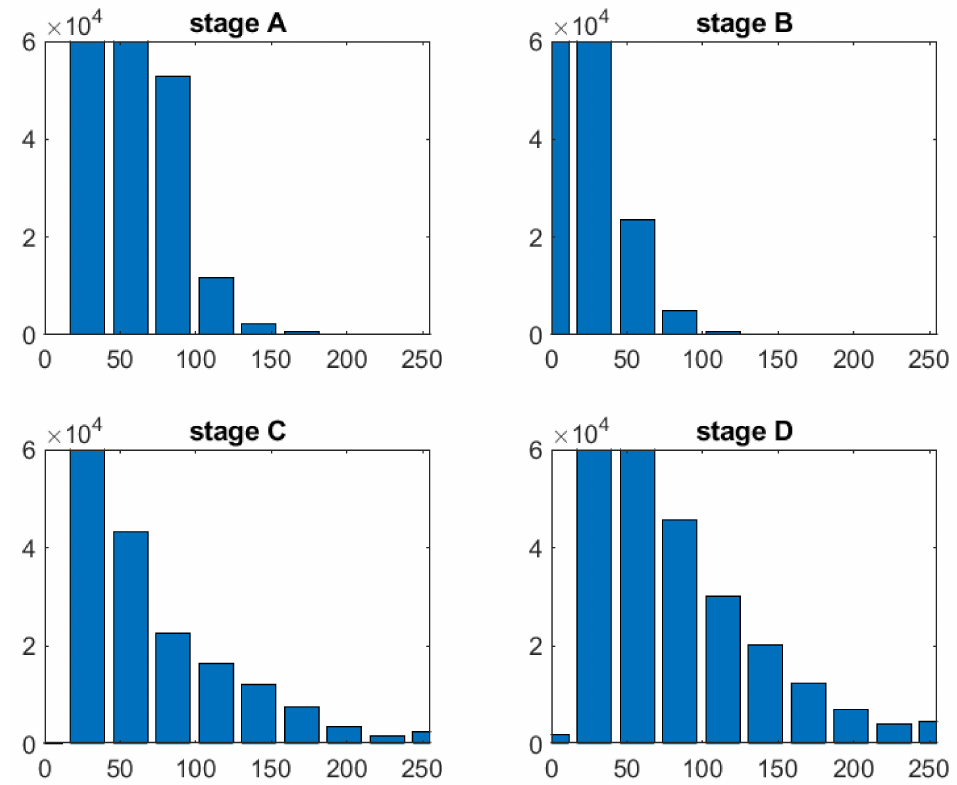
Figure 14. Original images